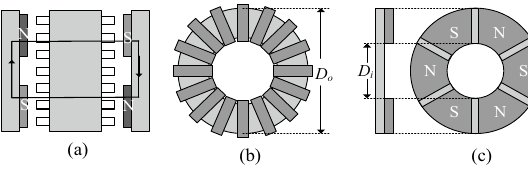
Figure 3 Sectional view of a torus-NS motor: a Magnetic circuit, b Stator structure, and c Rotor structure